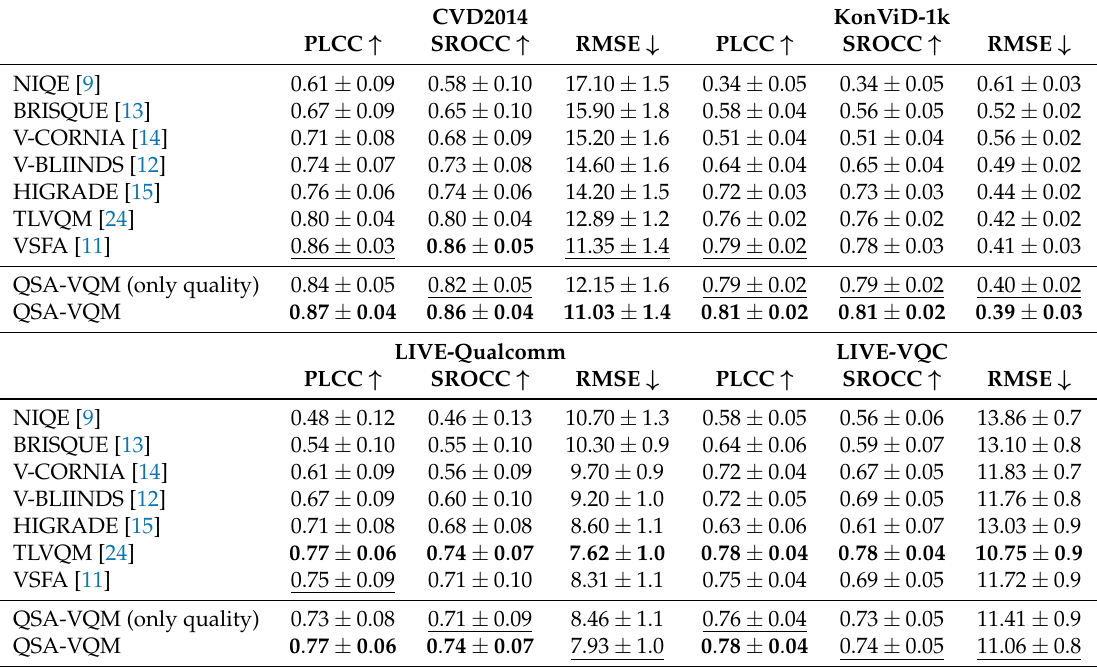
Table 2. Mean Pearson’s Linear Correlation Coefficient (PLCC), Spearman’s Rank-order Correlation Coefficient (SROCC), and Root Mean Square Error (RMSE) across 100 train-val-test combinations on the four considered databases. In each column, the best and second-best values are marked in boldface and underlined,